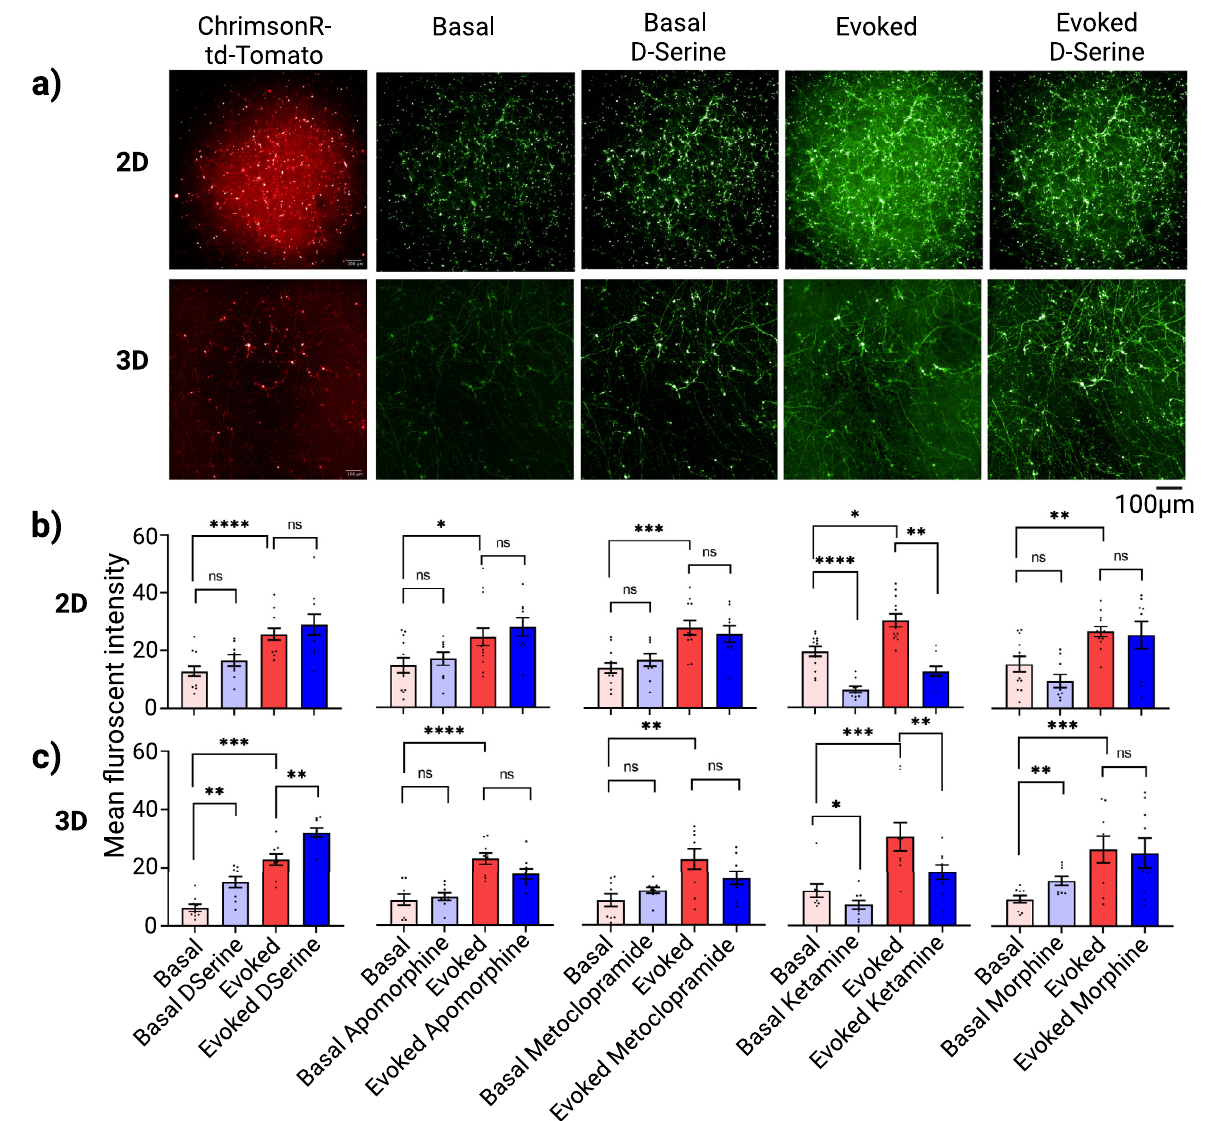
Fig. 8 Image-based quantitation and pharmacological modulation of glutamate release with a genetically encoded glutamate sensor in iGlutas/iAstros 2D and 3D co-cultural models. The genetically encoded glutamate biosensor, iGluSnFr was used to quantitate release of glutamate neurotransmitter in both 2D and 3D gel neural co-culture models. a Representative images of expression of ChrimsonR (red) via td-Tomato fl uorescence, glutamate neurotransmitter release via iGluSnFr (green) with af fi nity towards Glut1 transporter of glutamatergic neurons, which locates multiple release sites along the neurite ’ s length, for both basal and optical stimulation, and with or without D-serine, the NMDA-receptor agonist treatment. b and c Quantitation of mean fl uorescent intensity from multiple fi elds of views for 2D system ( n = 9 wells) and from entire z-stack along with multiple fi elds of views for 3D system ( n = 9 wells) were accumulated from each experimental group and presented as bar plots. Quantitation of glutamate release by measuring green fl uorescence from iGluSnFr biosensor in 2D ( b ) and 3D ( c ) models, after 30 min treatment with D-serine, apomorphine, metoclopramide and ketamine at 10 µ M, and morphine at 15 µ M. Scale bar 50 µ m. Error bar s.e.m. three technical replicates, with n = 3 wells each. Statistic: Two-way ANOVA with post hoc turkey test between